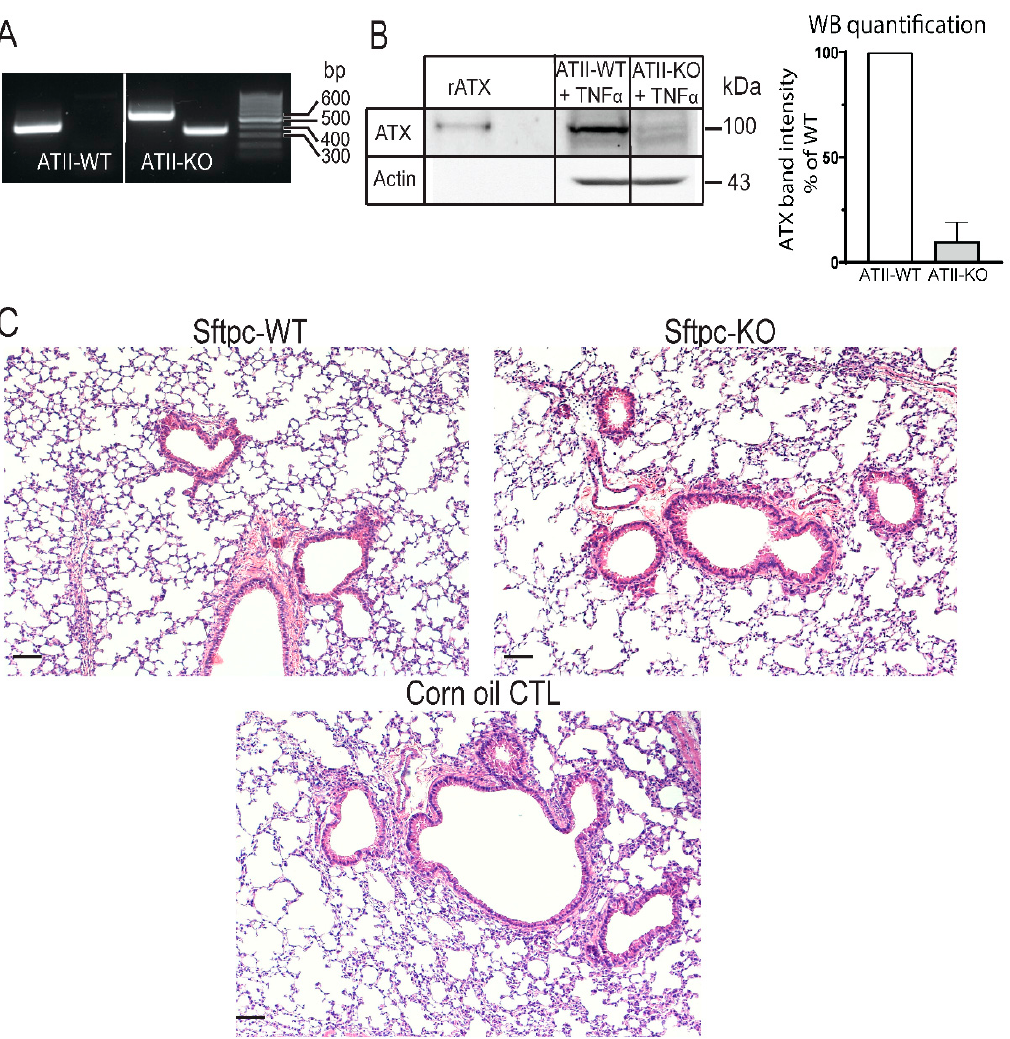
Figure 1. In vitro characterization of Sftpc-WT and Sftpc-KO mice. ( A ) Agarose electrophoresis of PCR-amplified Enpp2 allele of ATII cells isolated from Sftpc-WT (lanes 1 and 2) and Sftpc-KO (lanes 3 and 4) mice, treated in vivo with TAM (100 mg/kg/day for 5 days). The size of the Enpp2 WT allele is 441 bp, Enpp2 floxed allele is 540 bp, and Enpp2 deleted allele is 370 bp. The PCR product from ATII cells isolated from Sftpc-WT mouse showed a band corresponding to Enpp2 WT allele (lane 1) and no Enpp2 deleted allele was detected (lane 2). In contrast, ATII cells isolated from Sftpc-KO mouse showed a floxed allele (lane 3) and a deleted Enpp2 allele (lane 4). ( B ) WB analysis of cell lysates from ATII cells from Sftpc-WT mice (lane 2) and Sftpc-KO mice (lane 3) treated with TAM. Recombinant ATX (rATX, lane 1) was used as a positive control. Two weeks post-TAM treatment, ATII cells were isolated from Sftpc-WT and Sftpc-KO mice and put in culture for 5 days. Eighteen hours prior to lysate being harvested, cells were cultured in serum-free medium + 10 ng/mL of TNF α , in order to stimulate ATX production. One hundred fifty micrograms of protein was loaded into an 8% SDS-PAGE. A ~100 kDa band corresponding to ATX can be observed. Graph of the densitograms represents the percent of ATX band intensity normalized to the WT. ATII cells isolated from Sftpc-KO mice show a 90% decrease in band intensity (mean ± SD of 3 independent experiments). ( C ) Representative images of H&E stained 5 μ m lung sections from TAM-treated naïve Sftpc-WT ( left ) and Sftpc-KO ( right ) and corn-oil-treated control ( lower panel) mice. There was no sign of major histopathological lesion observed between the three different cohorts of lungs. Lungs were harvested two weeks post-TAM treatment, inflated with 10% formalin, fixed, and sectioned. Scale bars represent 100 μ m (10× magnification). 3.2. Generation and Characterization of ATX-KO B16-F10 Cell Line